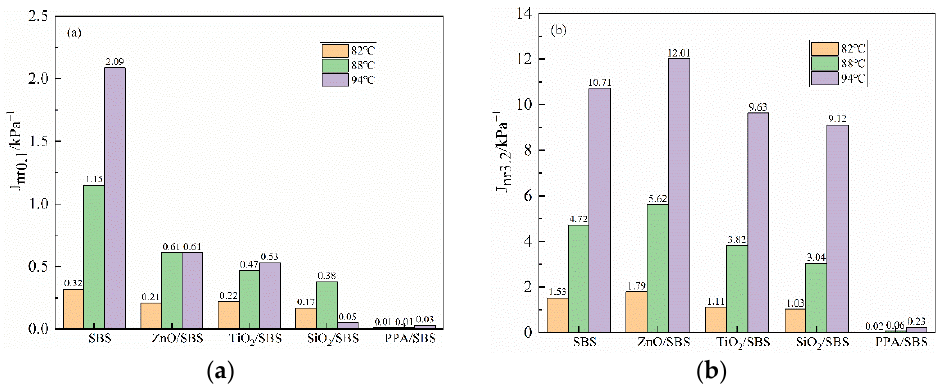
Figure 2. Irreversible creep compliance of asphalt at different stress levels and temperatures after RTFO aging: ( a ) J nr0.1 ; ( b ) J nr3.2 .